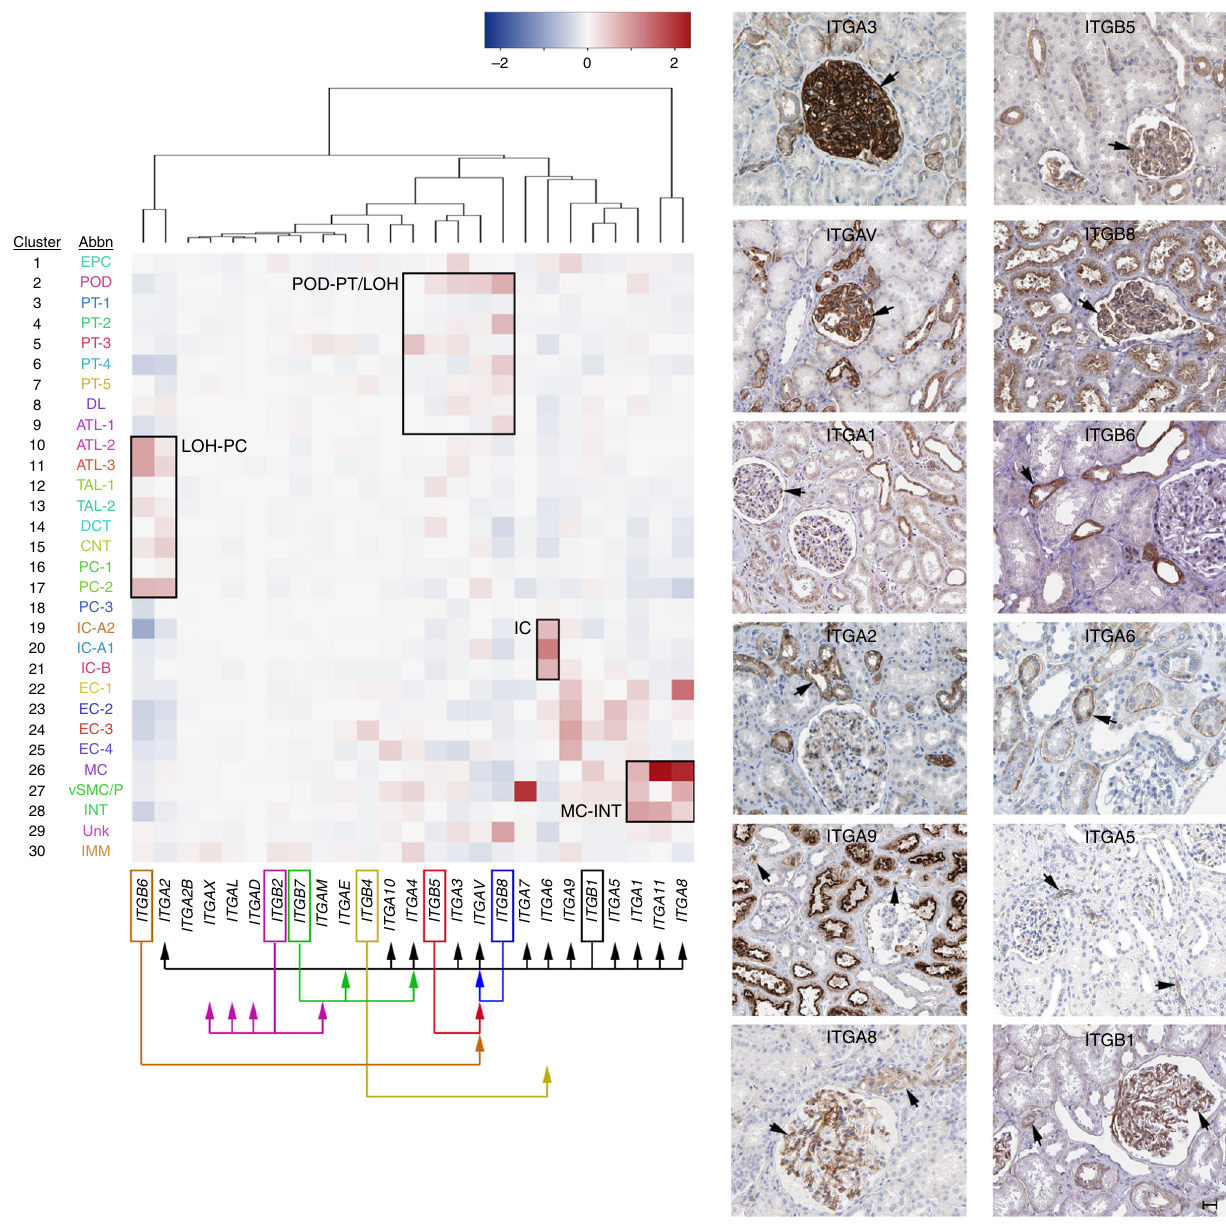
Fig. 6 Integrin expression dynamics in the kidney. a Heatmap of averaged scaled gene expression values for integrins detected in the adult human kidney clusters. Enrichment for speci fi c integrins and their indicated binding partners (arrows) were found for speci fi c cell types or nephron segments. Source data are provided as a Source Data fi le. b Protein immunostainings (Human Protein Atlas 49 , Supplementary Data 16) for select integrins that showed cluster- enriched RNA expression shown in ( a ). Arrows indicate associated cell types/structures showing enrichment predicted from snDrop-seq data ( a ). Scale bar indicates 25 µ